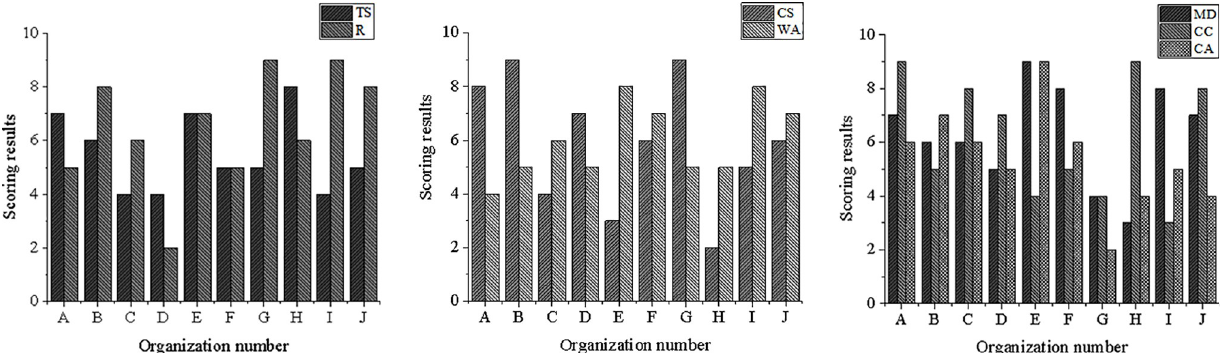
Fig 5. Scoring statistics of the HRM assessment management module. (a) TS and R indicator scores. (b) CS and WA indicator scores. (c) MD, CC, and CA indicator scores.